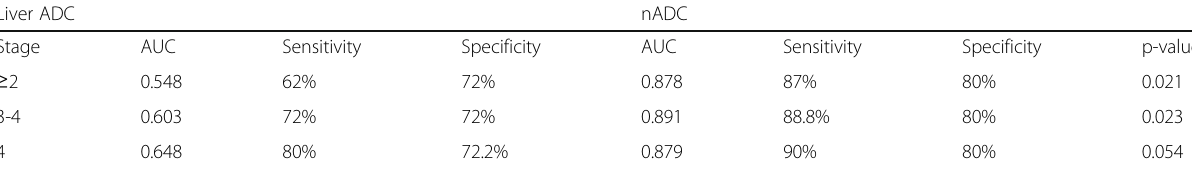
Table 6 nADC liver exhibited good diagnostic performance for each stage of fibrosis Compared to ADC liver Liver ADC nADC